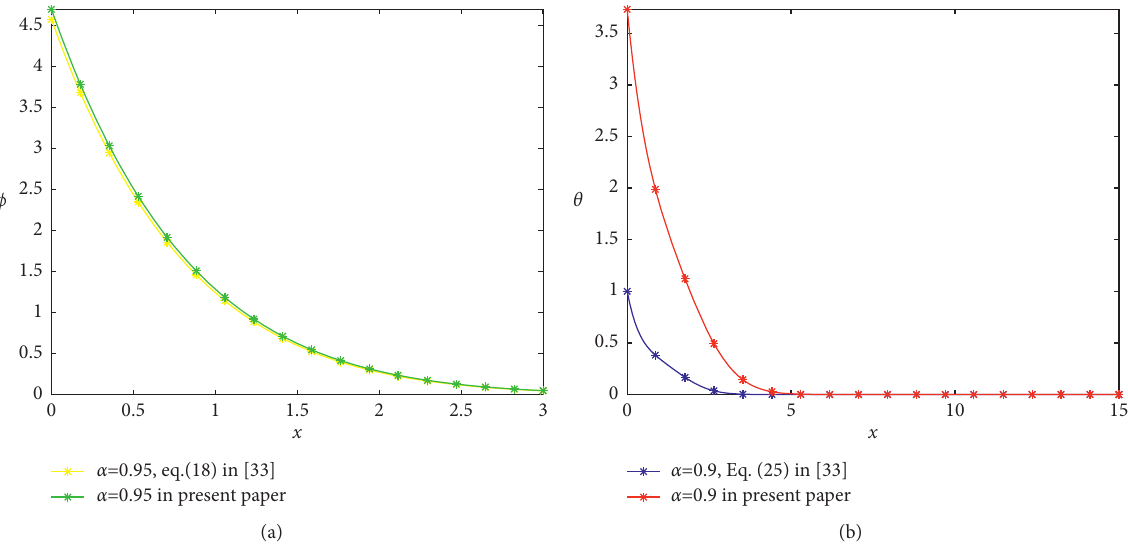
Figure 14: Comparative studies concerning temperature and concentration